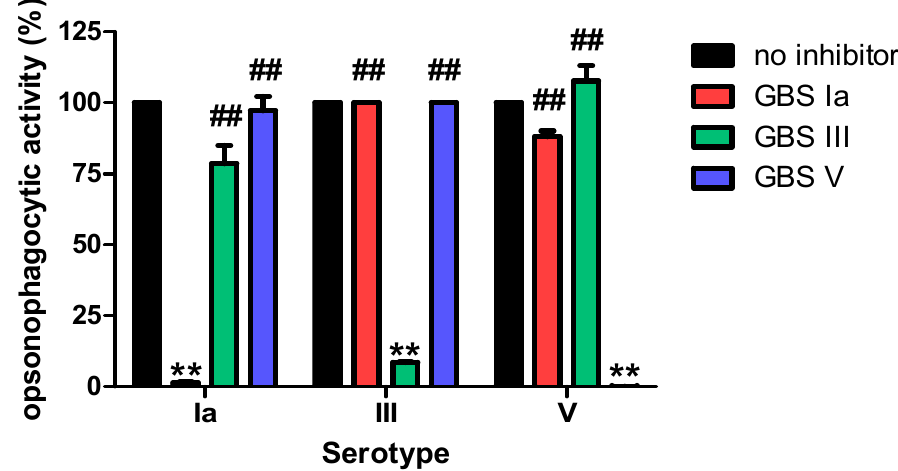
Figure 4. Opsonophagocytic killing assay (OPA) performed by adsorption with inactivated group B Streptococcus (GBS) Ia, III, or V in pooled serum samples. This assay was conducted in triplicate. Error bars are standard deviations of each condition. ** p < 0.01 compared to the results without inhibition by inactivated GBS (no inhibitor). ## p < 0.01 compared to the results with inhibition by homologous serotype inactivated GBS.